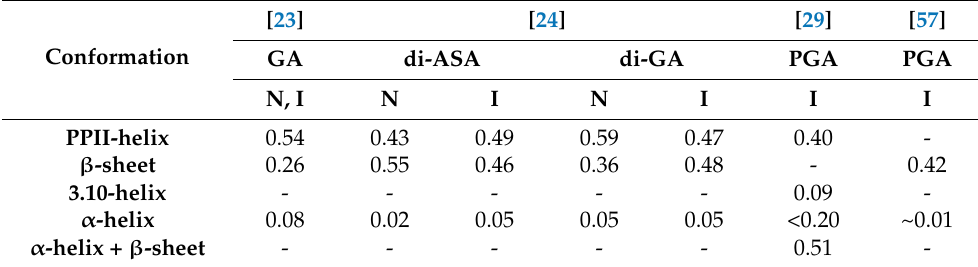
Table 1. Experimental fractions of the different conformations (basins) of aspartic acid (ASA) and glutamic acid (GA) residues in neutral (N) and ionized (I) states. The first column: data for the glycine-glutamic-glycine (Gly-GA-Gly) tripeptide from Ref. [23]; the second column: data from Ref. [24] for the ASA and GA dipeptides; the last two columns: data from Refs. [29,57] for PGA.